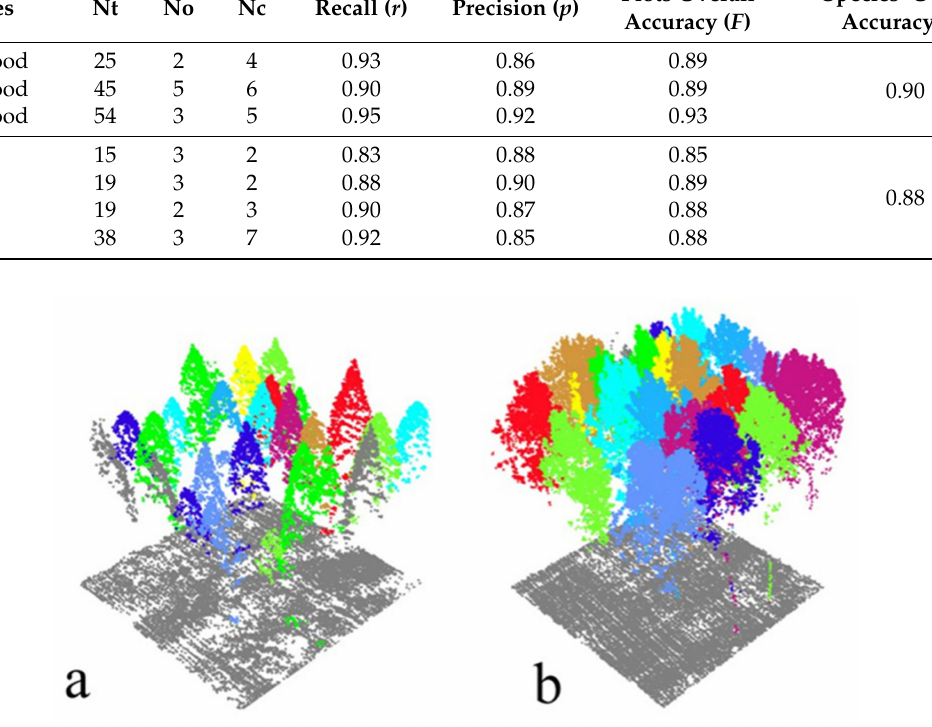
Table 2. Assessment of the accuracy of the ULS point cloud data segmentation. Nt: the number of treetops detected that existed in the field position; No: the number of trees that were omitted by the algorithm; Nc: the number of detected trees that did not exist in the field; r : detection rate; p : the precision of detected trees; F : overall accuracy. Plots